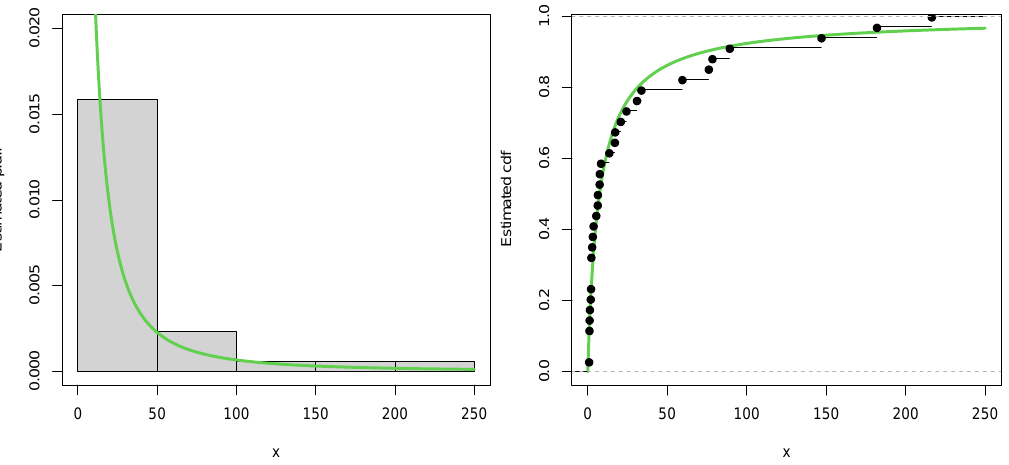
Figure 9. Estimated p.d.f ( left ) and CDF ( right ) of the GAEPPR model corresponding to runoff data.